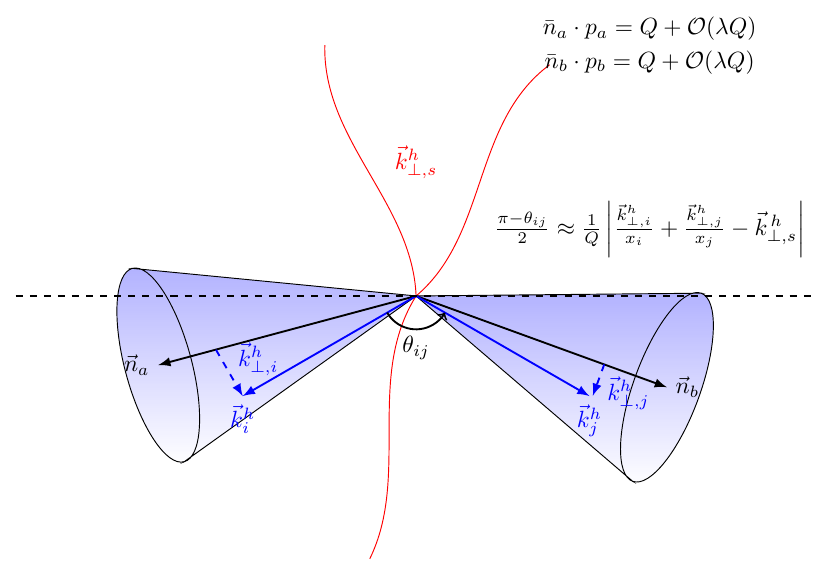
Figure 1 . The kinematics of the EEC in the back-to-back limit. Wide angle soft radiation recoils the two jets in a manner identical to the case of p T for color singlet boson production in hadronic collisions. This provides a precise relation between the factorization formulas in the two cases. (Figure from